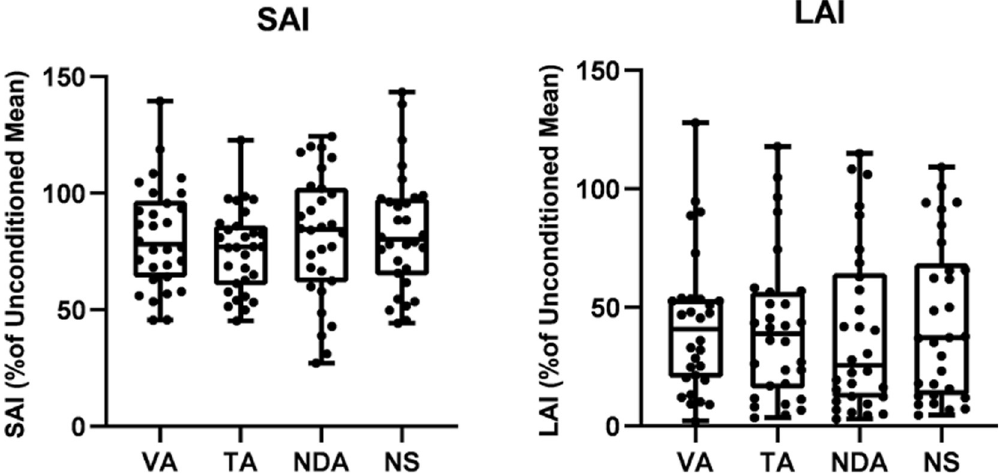
Fig 2. Biological effects of attention. A. Average SAI, expressed as a % of the unconditioned mean at. T1. Shown is the mean with whiskers spanning 1.5 Χ the interquartile range. B. Average LAI, expressed as a % of the unconditioned mean. Shown is the mean with whiskers spanning 1.5 Χ the interquartile range LAI : long latency afferent inhibition , NDA : non-directed attend , NS : no stimulation , SAI : short latency afferent inhibition , TA : tactile attend , VA : visual attend .